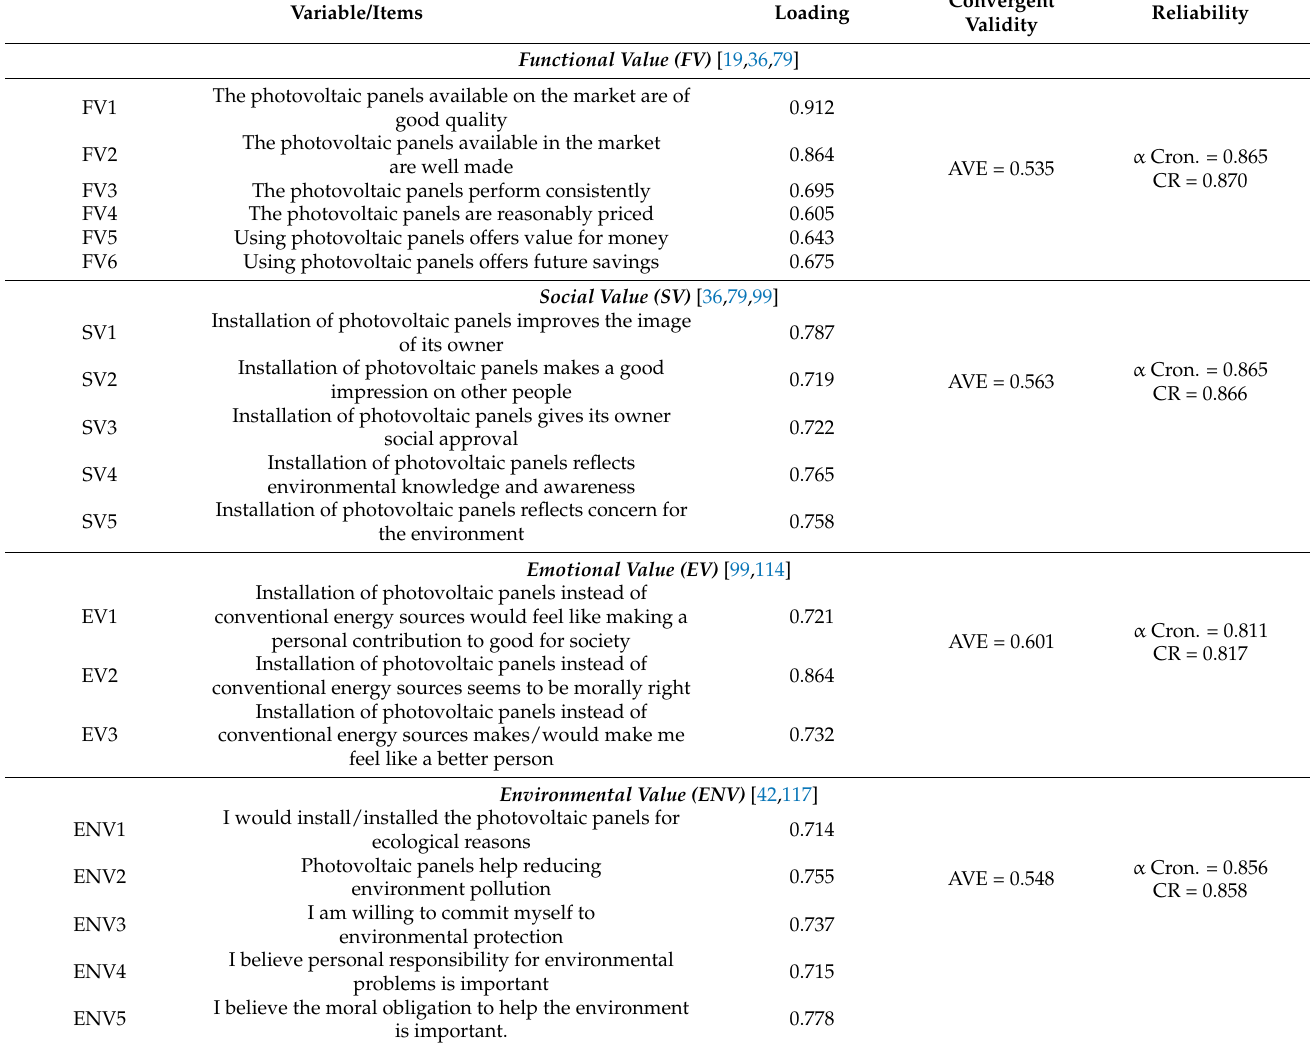
Table 2. Factor loadings, convergent validity, and reliability of variables